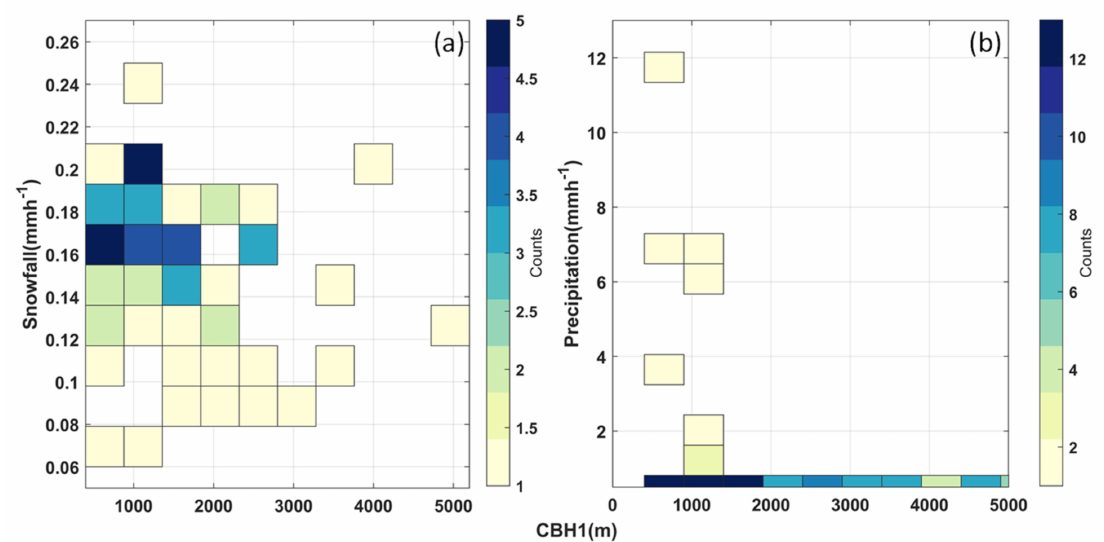
Figure 9. Joint histogram plots for ( a ) CBH1 vs. snowfall rate and ( b ) CBH1 vs. precipitation for the periods the same as Figure 8. The colour bar indicates the bin counts for each variable.